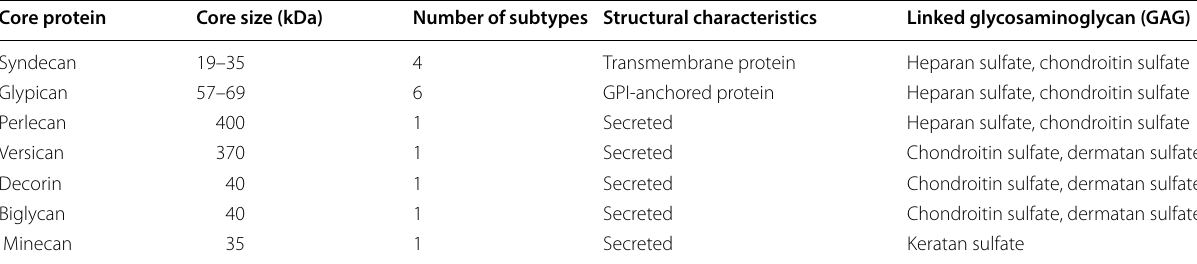
Table 1 Characterization of proteoglycan core proteins in the glycocalyx. Adapted from [5]